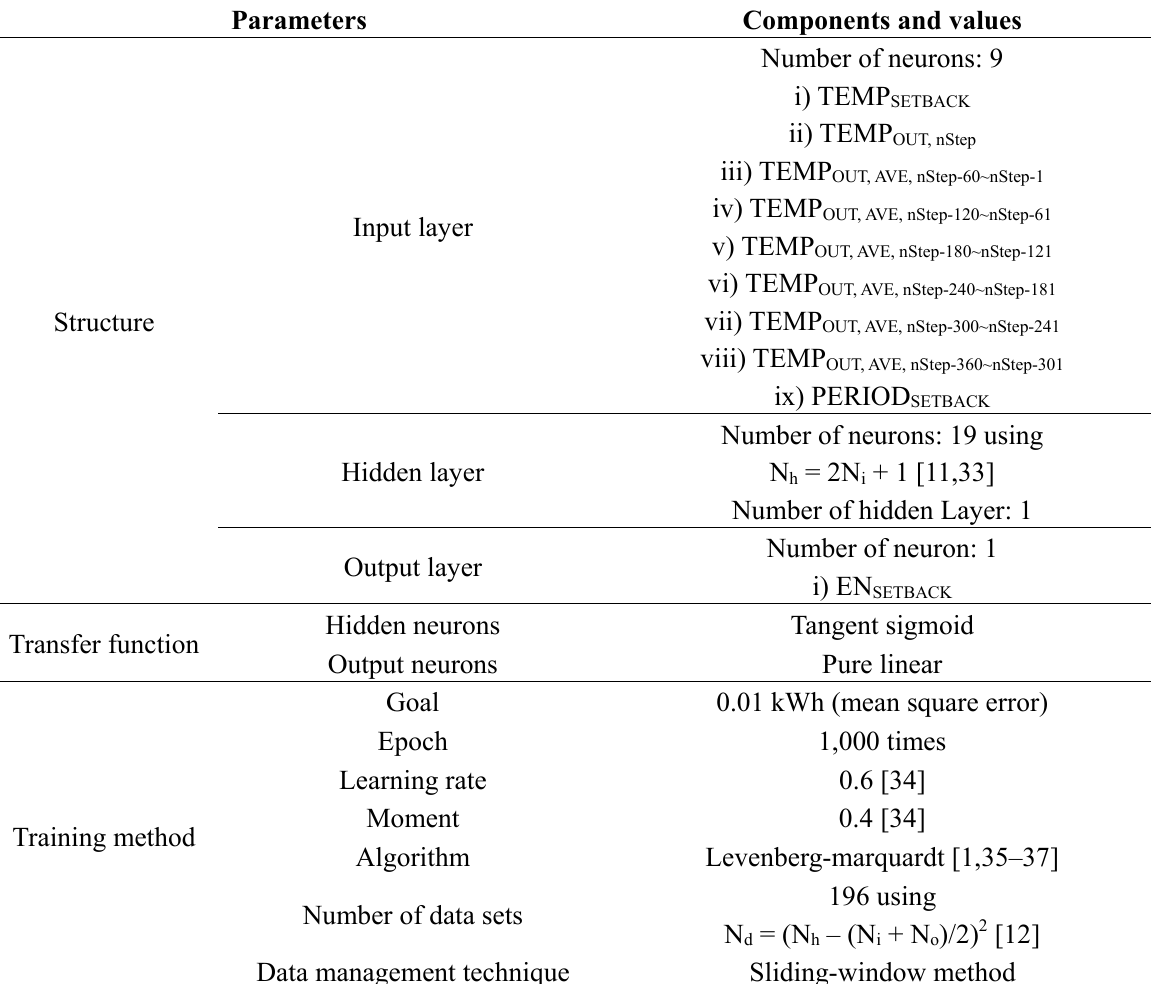
Table 1. Composition of the initial prediction